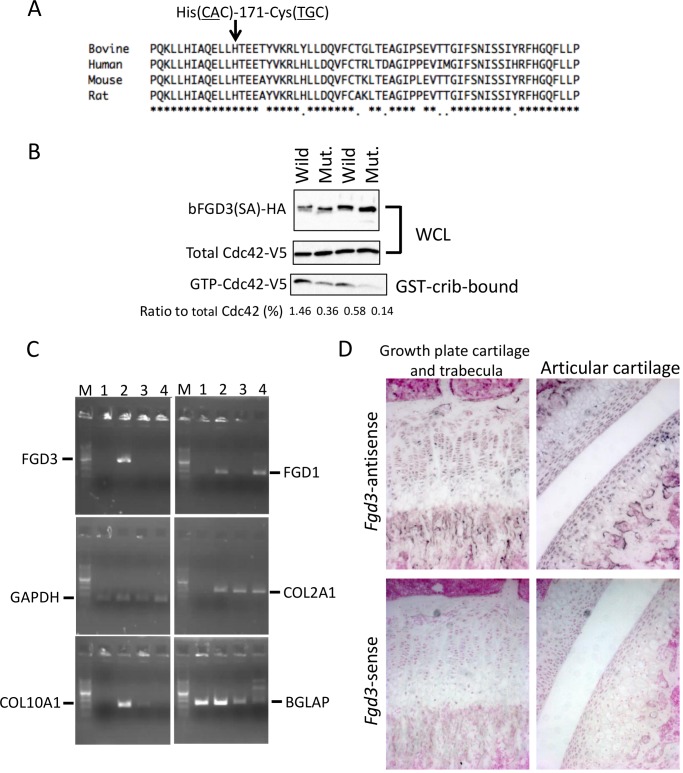
Amino acid sequence alignment around His-171, GEF activity, and gene expression of FGD3.(A) His-171 of bovine FGD3 and the flanking region is well conserved among mammalian species. The RhoGEF domain corresponds to the region from His-164 to Ala-344 of bovine FGD3. (B) NIH3T3 cells were transfected with the bicistronic expression plasmid encoding HA-tagged wild or mutant bovine FGD3(SA) and V5-tagged Cdc42. FGD3(SA) denotes FGD3 with two serines in the destruction motif (Ser-83 and Ser-87 of bovine FGD3) replaced by alanines [24]. After 48 hours, cell extracts were prepared and submitted to the GST–CRIB pull-down assay. A portion of cell extracts and the pull-down products were subjected to SDS-PAGE followed by immunoblotting to detect Cdc42-V5 and FGD3(SA)-HA. The experiment was repeated two more times, and the results are shown in S4 Fig. (C) RNA was extracted using RNAiso Plus (Takara) from tissues of a 1-month-old Holstein calf. Primary chondrocytes were prepared from the ear cartilage and cultured as micromass. Five days later, RNA was extracted from the micromass using an RNeasy kit (QIAGEN, Valencia, CA, USA). RT-PCR was performed using a standard method and PCR primers given in S8 Table. PCR products were resolved in a 2% agarose gel. Lane M, 100-bp DNA ladder; lane 1, bone marrow just under the growth plate of a femur; lane 2, growth plate cartilage of the femur; lane 3, ear cartilage; lane 4, micromass culture from the ear cartilage. (D) In situ hybridization of Fgd3 on the femur of a 3-week-old C57BL/6 mouse. Sense and antisense RNA probes correspond to nt. 129–956 of the mouse Fgd3 cDNA (NM_015759).